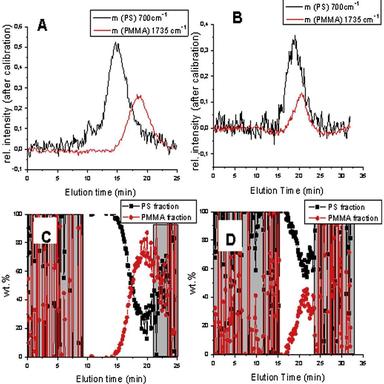
FTIR elution profiles and chemical compositions as a function of elution time for PS and PMMA blends SM1 (A and C) and SM2 (B and D).